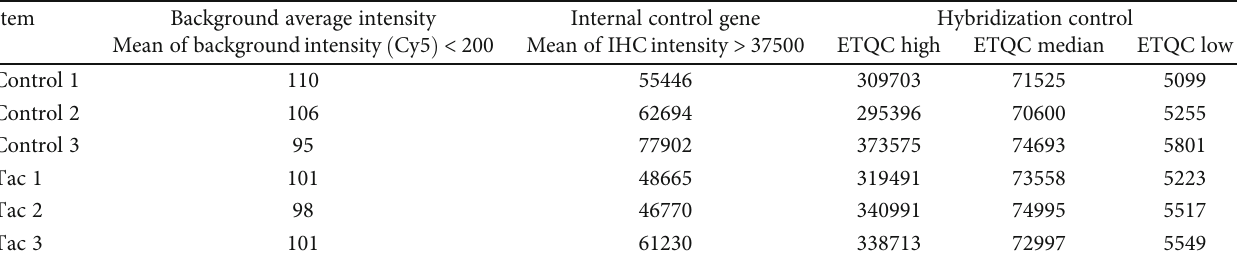
Table 2: Quality control result.